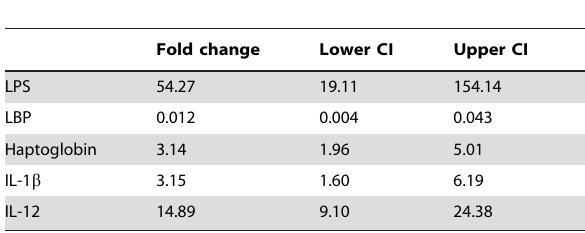
Table 3. Fold-change for geometric mean of CP Ag + group compared to others, with (unadjusted) 95% confidence intervals